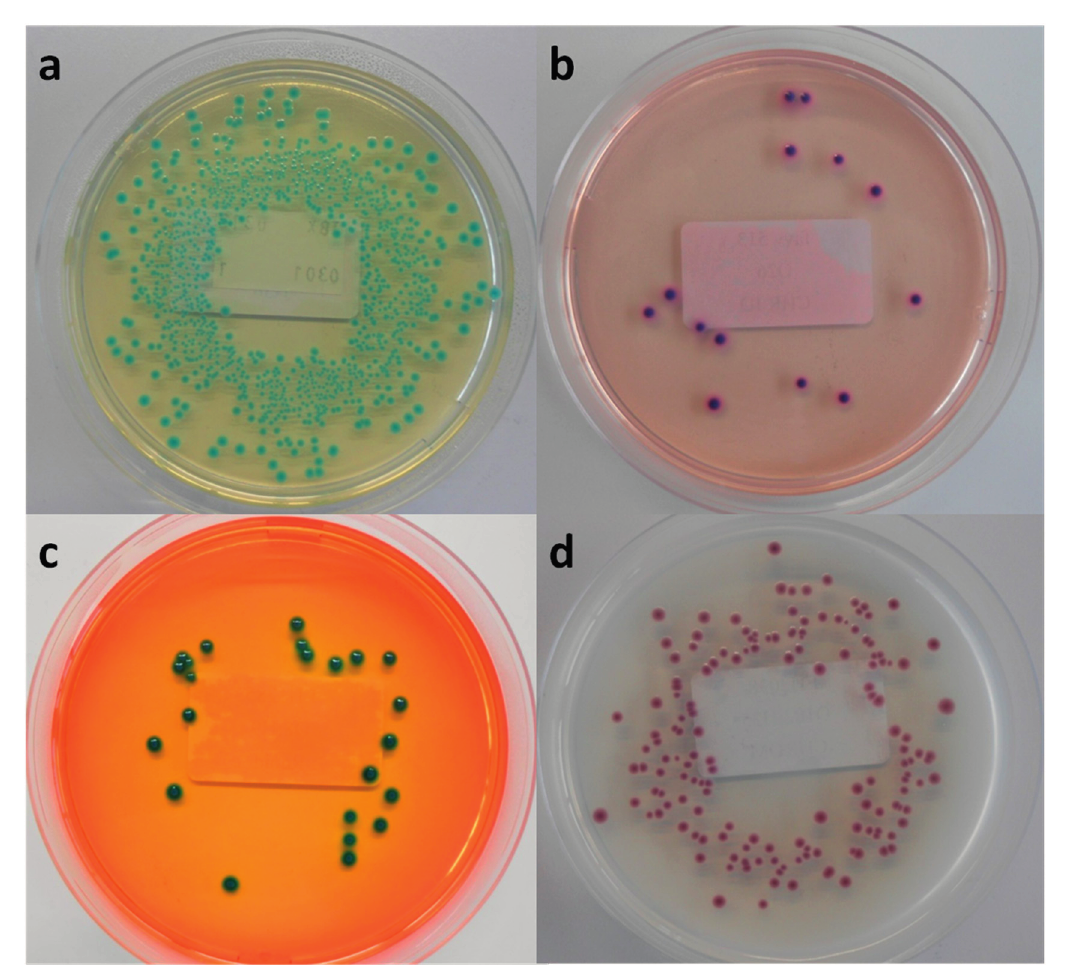
Figure 1. Macroscopic view of ( a ) Tryptone Bile X-glucuronide agar (TBX), ( b) chromID EHEC agar (Chr ID), ( c ) Rapid E. coli O157:H7 agar (RE) and ( d ) CHROMagar STEC (Chr ST), inoculated with MB 5316 ( a ), MB 5948 ( b ), MB 5322 ( c ) and MB 5341 ( d